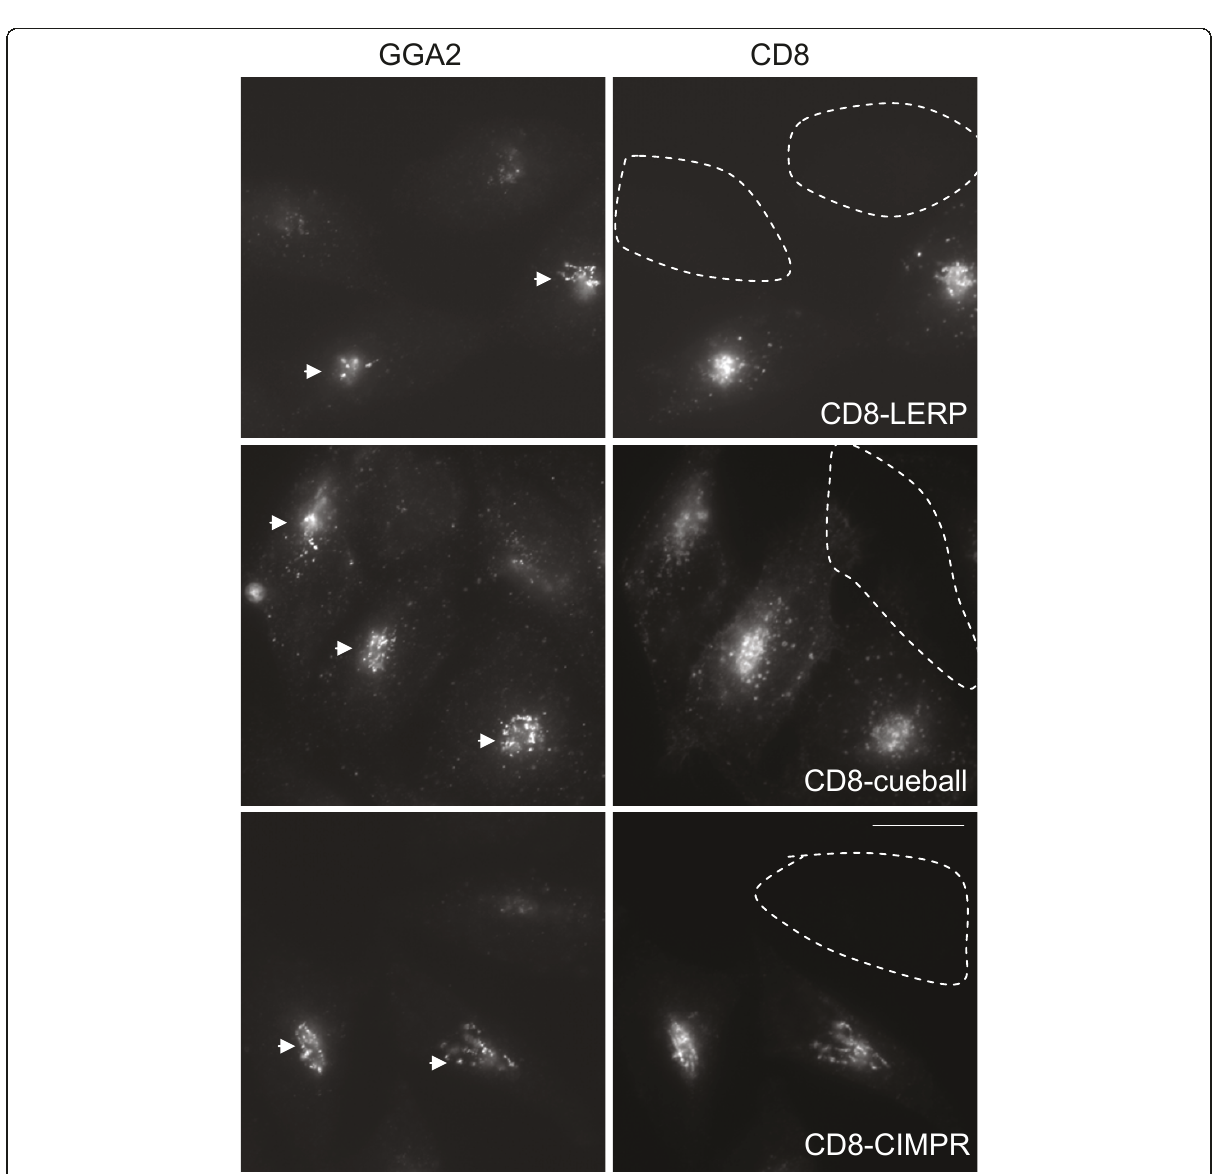
Figure 8 Expression of a CD8-cueball reporter construct increases GGA2 recruitment in HeLa cells . The cytoplasmic tails of CIMPR, LERP and cueball were expressed in a CD8 reporter system. Transient expression of CD8-CIMPR, CD8-LERP and CD8-cueball in HeLa cells resulted in the increase of GGA2 recruitment to membrane as shown by the increase in fluorescence intensity in the juxtanuclear region of the cell (arrowhead). The encircled cells highlight cells where there is no expression of CD8-constructs. Bar, 20 μ